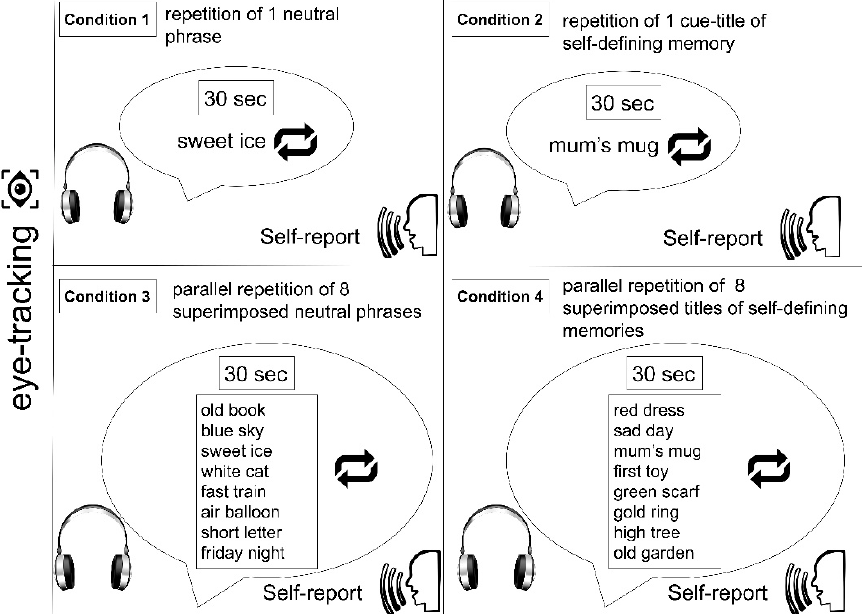
Figure 1. A schematic illustration of the experimental protocol. The conditions were separated by self-reports and one minute of rest.